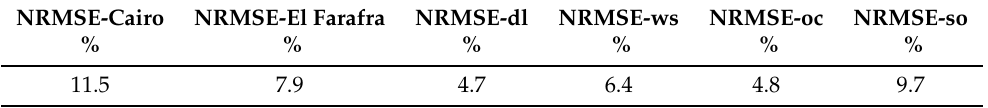
Table 4. Normalized Root Mean Square Error (NRMSE) of the six OLI surface reflectance obtained by OLI@CRI with the available microphysical properties of the aerosol: Cairo, El Farafra and the four basic components (dl for dust-like; ws for water-soluble; oc for oceanic; so for soot) with respect to the MOD09GA MODIS product on the study area.